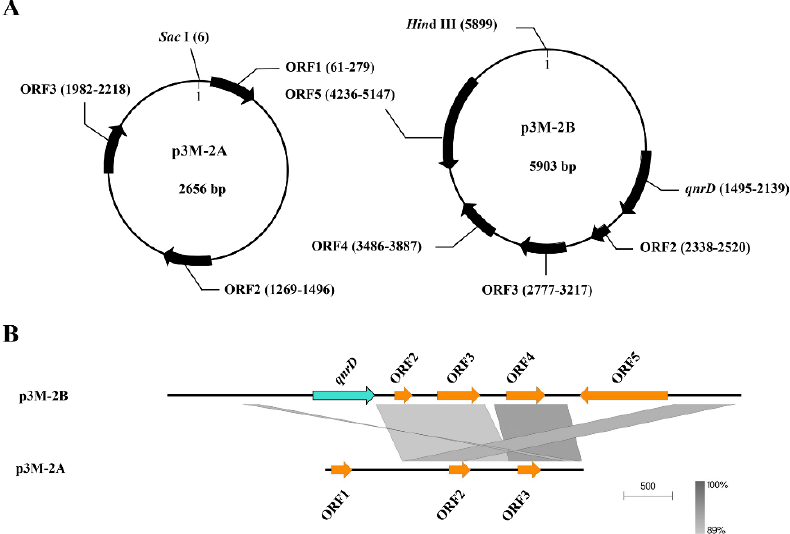
Figure 1. Graphical maps ( A ) and comparison of the structures ( B ) of p3M-2A and p3M-2B. The grey and dark shading in (b) indicates common regions between the plasmids.